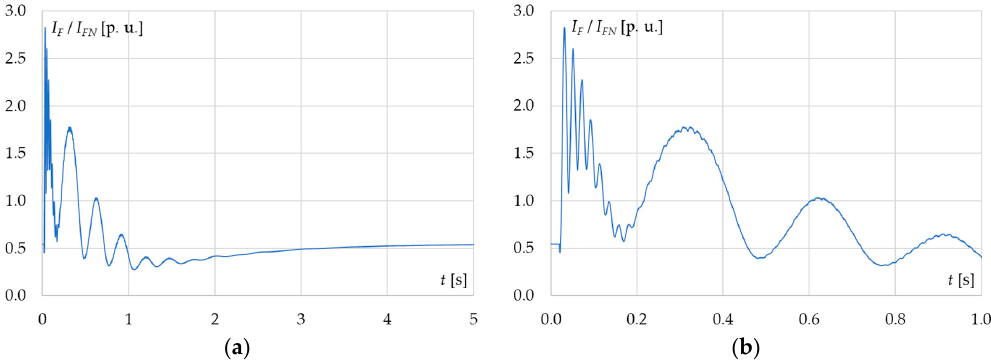
Figure 16. Waveform of field current during out-of-phase synchronization of − 120° in ( a ) the scope of the considered calculation time and ( b ) the first second.